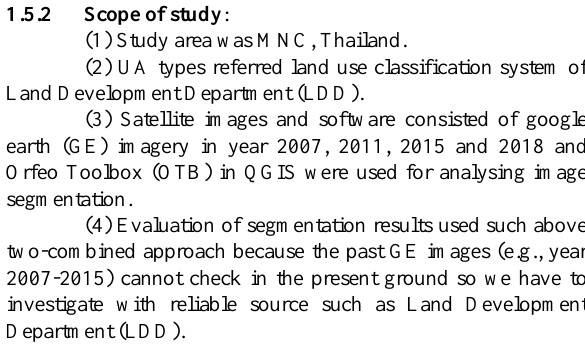
Figure 2. Procedure for this